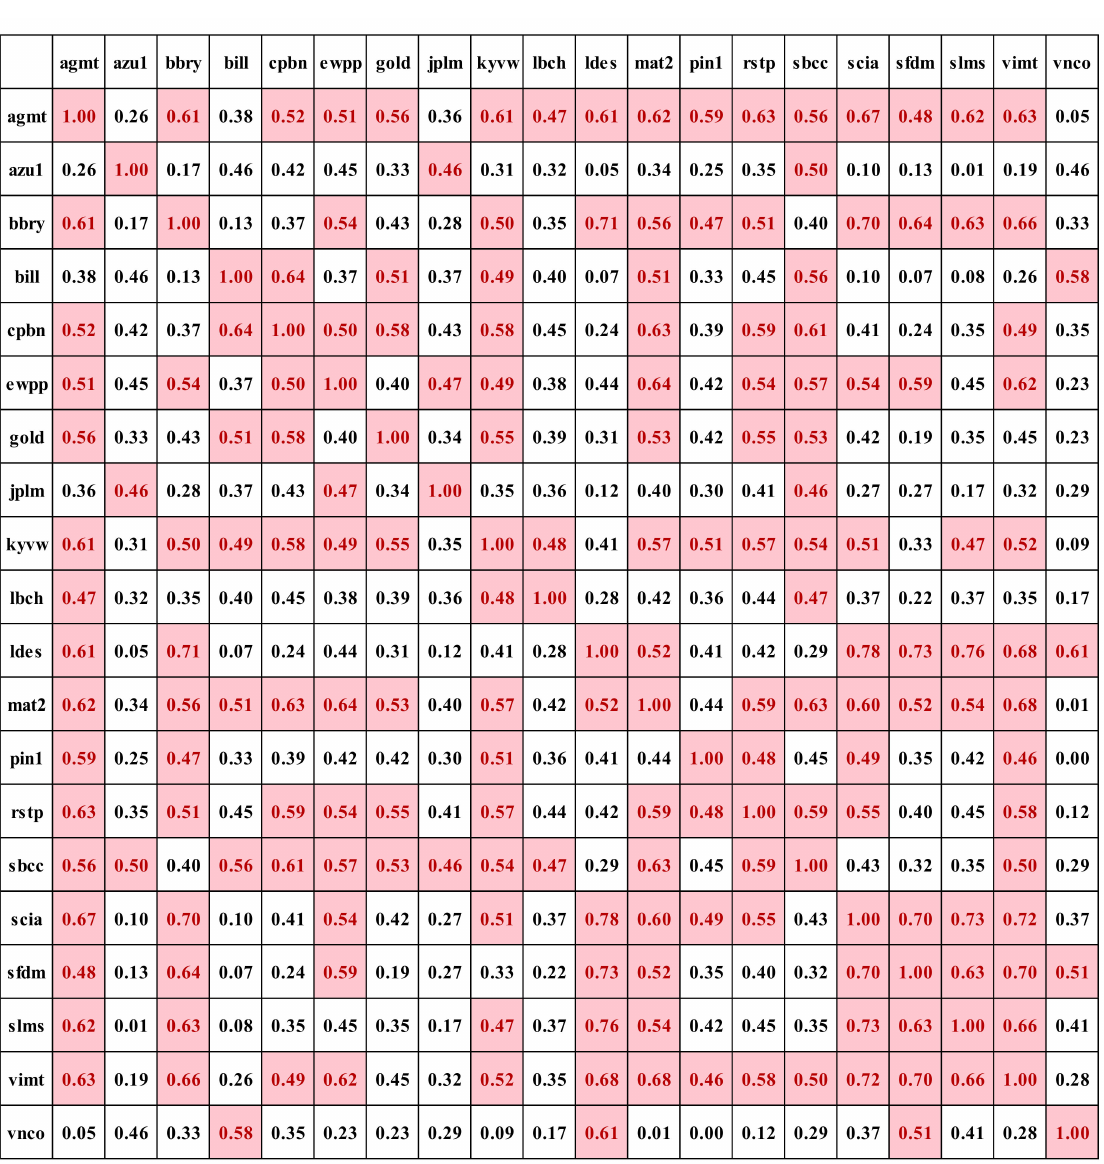
Figure 3. Spatial correlations between different stations (Red background represents higher